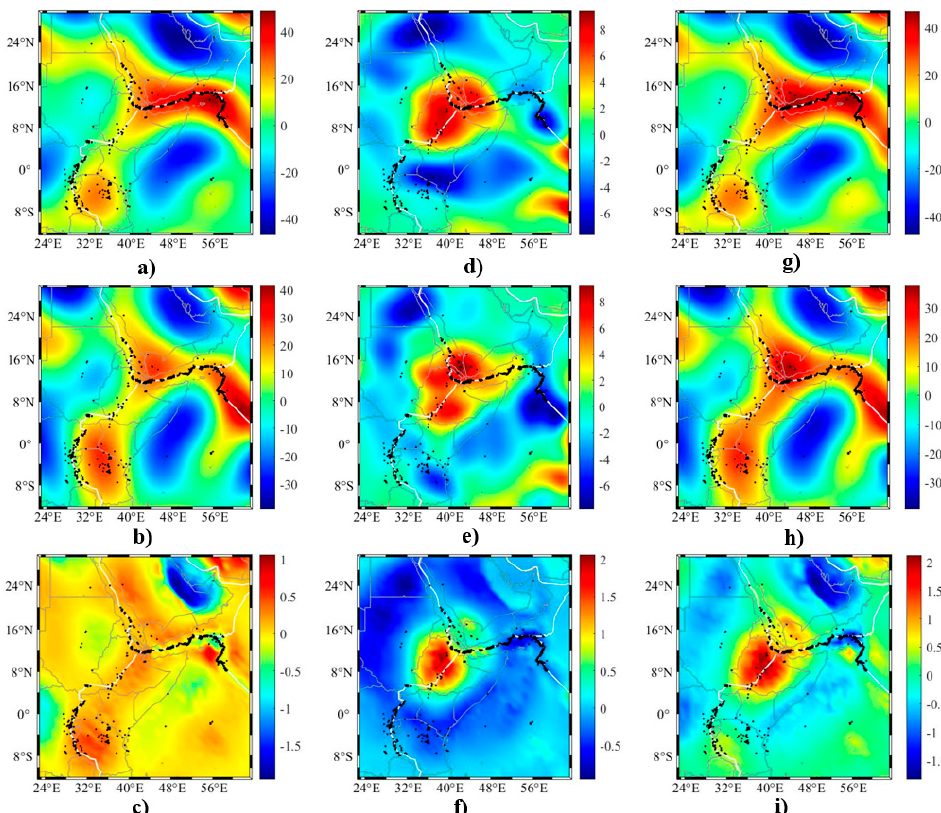
τ τ τ , ( b ) yy , and ( c ) zz from the τ τ τ , ( e ) yy , and ( f ) zz τ τ τ , ( h ) yy , and ( i ) zz from the